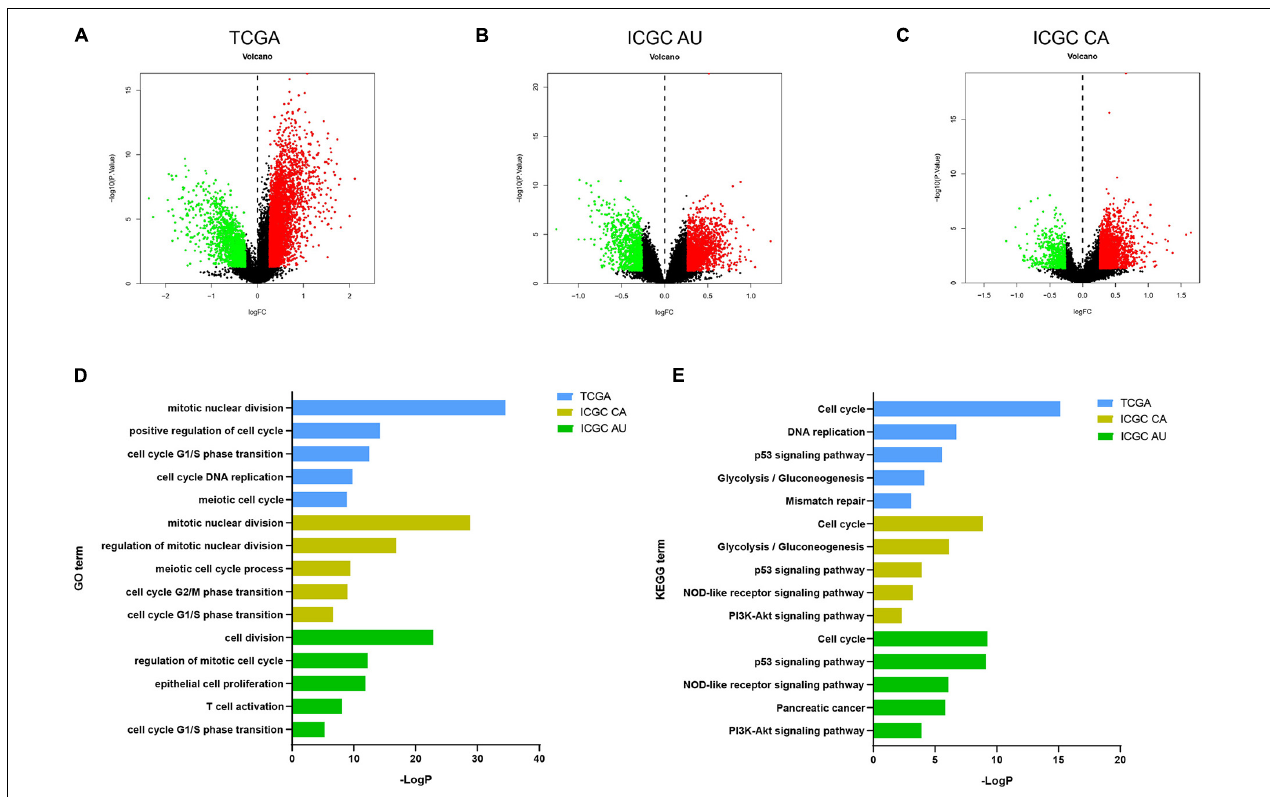
FIGURE 5 | Pathways involved in the immunity-related 18-gene signature. The volcano plot of DEGs in (A) TCGA, (B) ICGC AU, (C) ICGC CA databases. The volcano plots were constructed using fold-change and p values. Genes with fold-change > 1.2 and p < 0.05 were used to pathways analysis. (D,E) Similar GO and KEGG pathways enriched in high score group in TCGA, ICGC CA, and ICGC